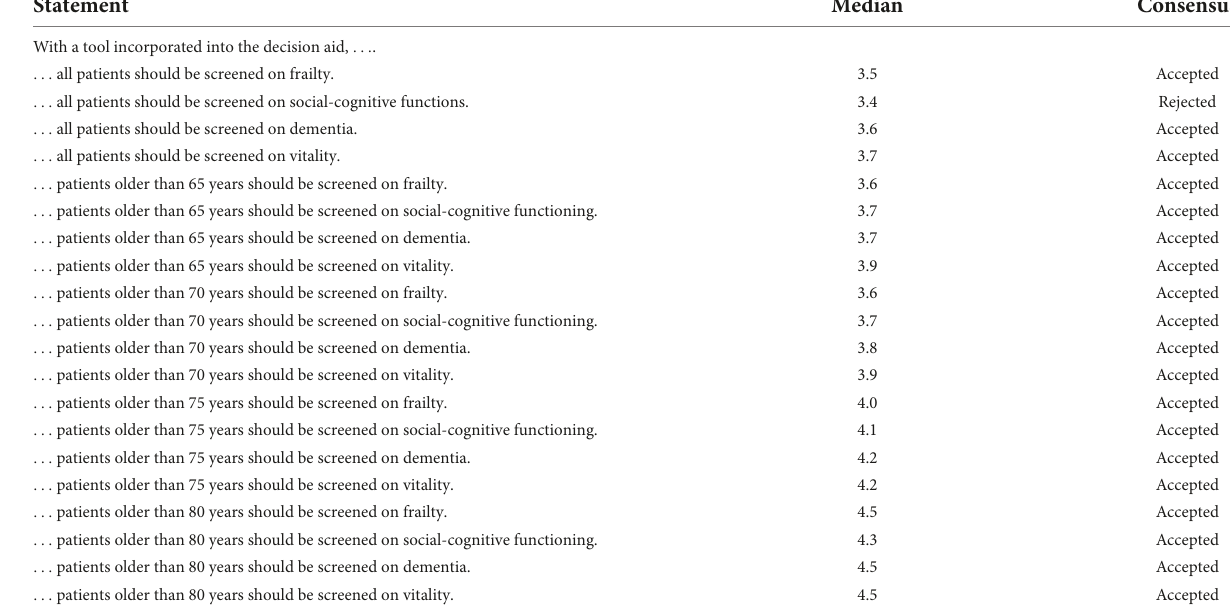
TABLE 3D Statements on which patients should be screened on what aspects, by tools integrated into the decision